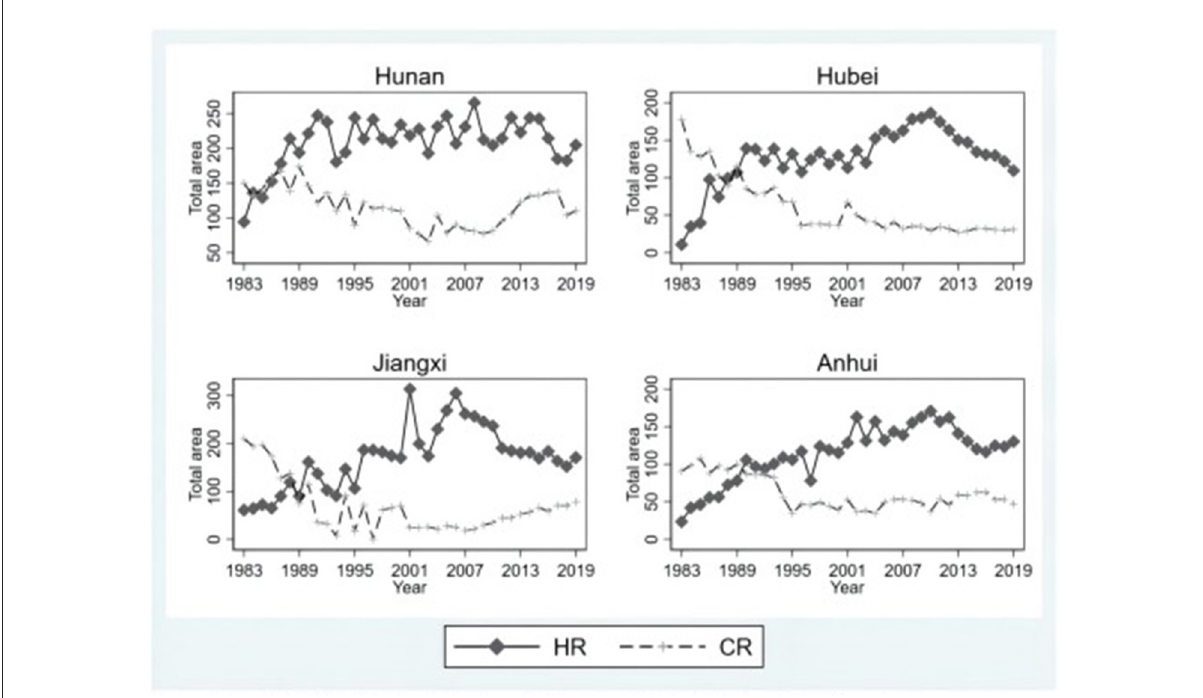
FIGURE2 Cultivation Area of HR and CR from 1983 to 2019 by Surveyed Provinces (unit: 10,000 ha). Source: Statistical Table of the Popularization of Main Crop Varieties in China, obtained from the China Agricultural Technology Extension Service Center. Notes: The data only includes rice varieties with a cultivation area larger than 100,000 mu (15 mu = 1